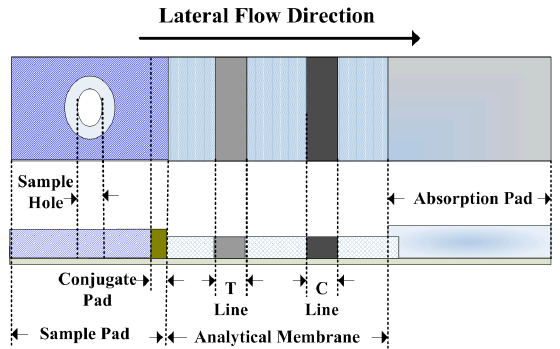
Figure 2. Schematic diagrams of the ICG assay test strip.